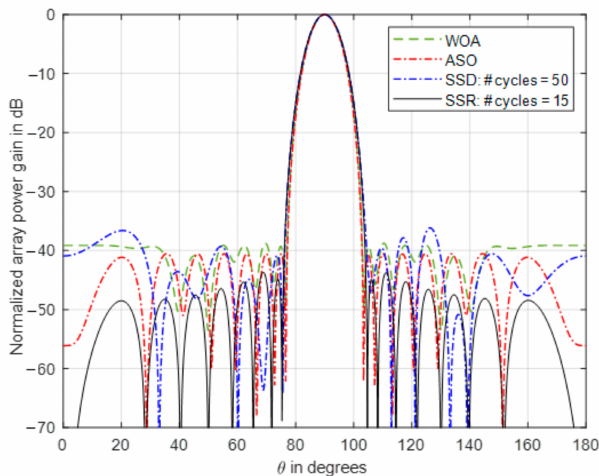
Figure 11. Normalized power pattern for 16-element linear array for different optimization tech- niques including WOA, ASO, and SSD compared with the proposed SSR algorithm.